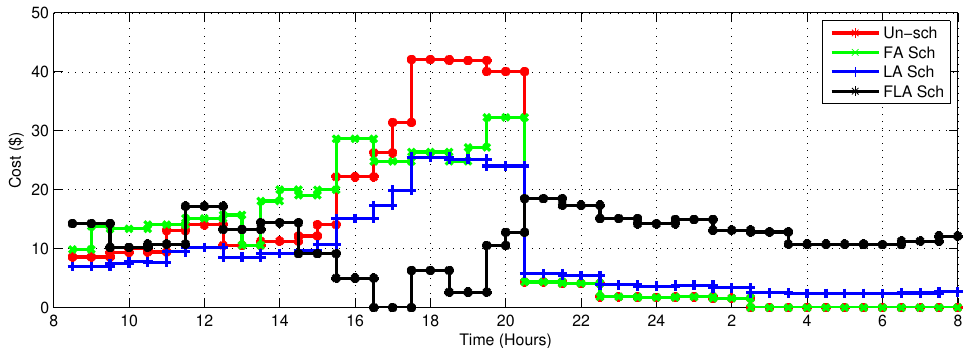
Figure 4. Hourly energy cost